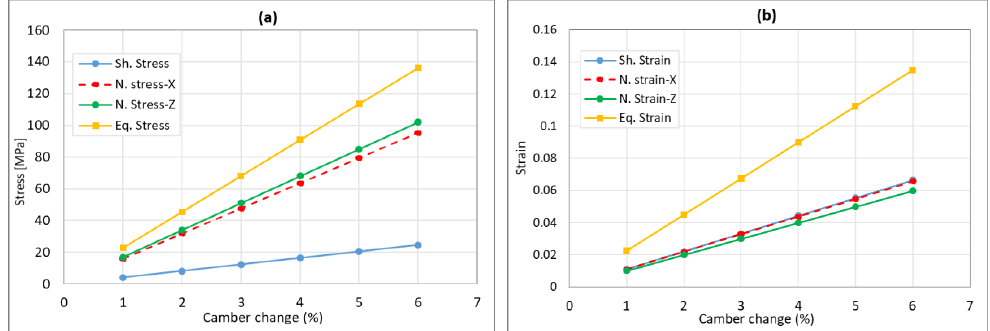
Figure 8. Wing model; ( a ) camber rate vs. stress and ( b ) camber rate vs. strain.